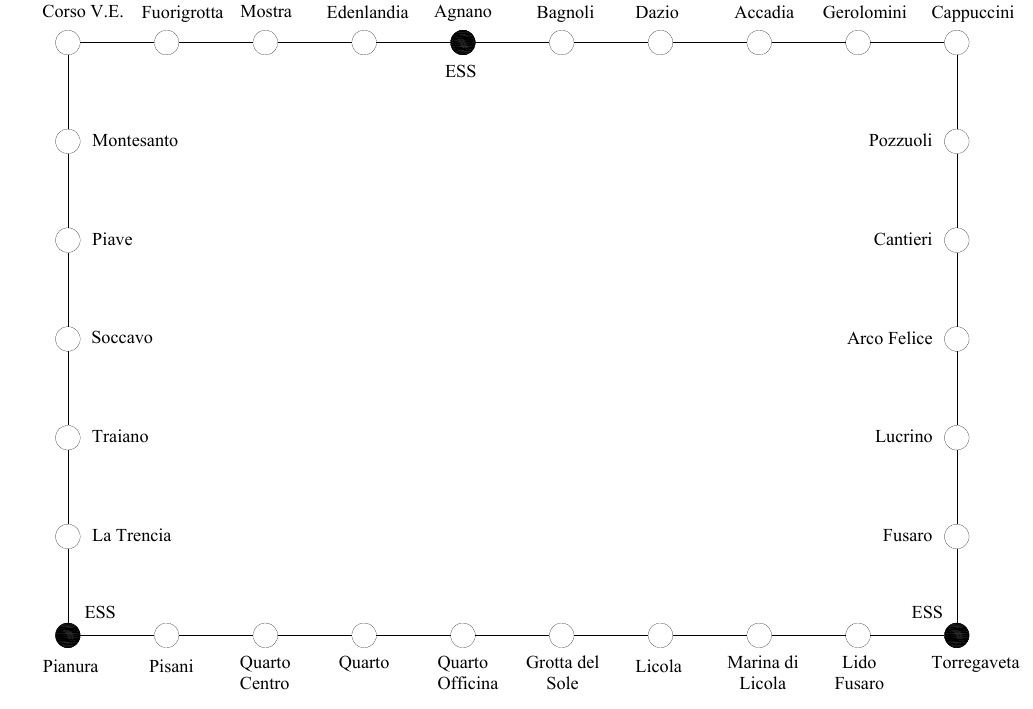
Figure 7. Configuration of the sample line considered.